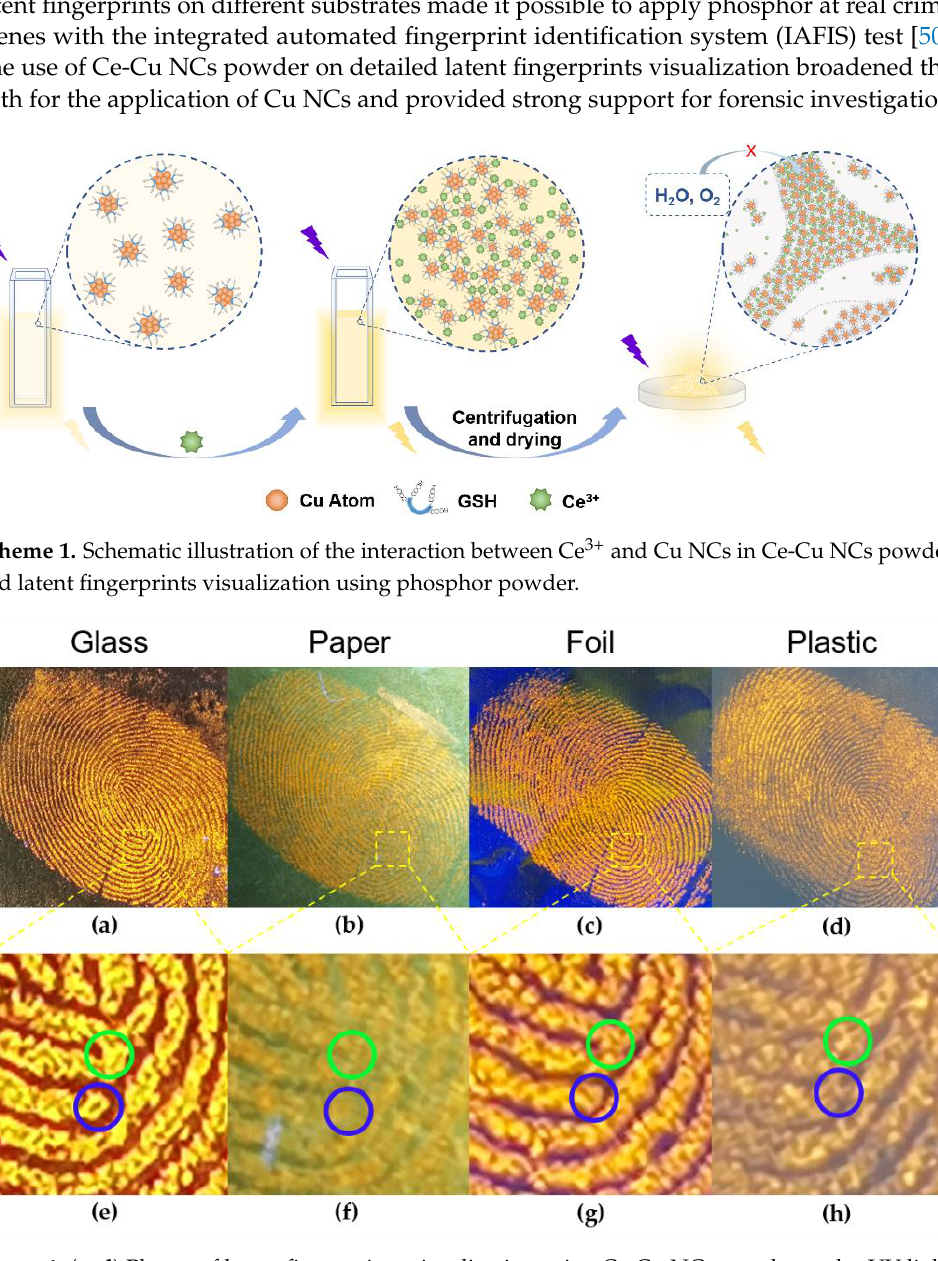
Figure 4. ( a – d ) Photos of latent fingerprints visualization using Ce-Cu NCs powder under UV light. ( e – h ) The zoomed-in details of labeled fingerprints in which the ridge termination points (green circle) and the bifurcation points (blue circle) were marked. Fingerprints were pressed on glass ( a , e ), paper ( b , f ), foil ( c , g ) and plastic ( d , h ).